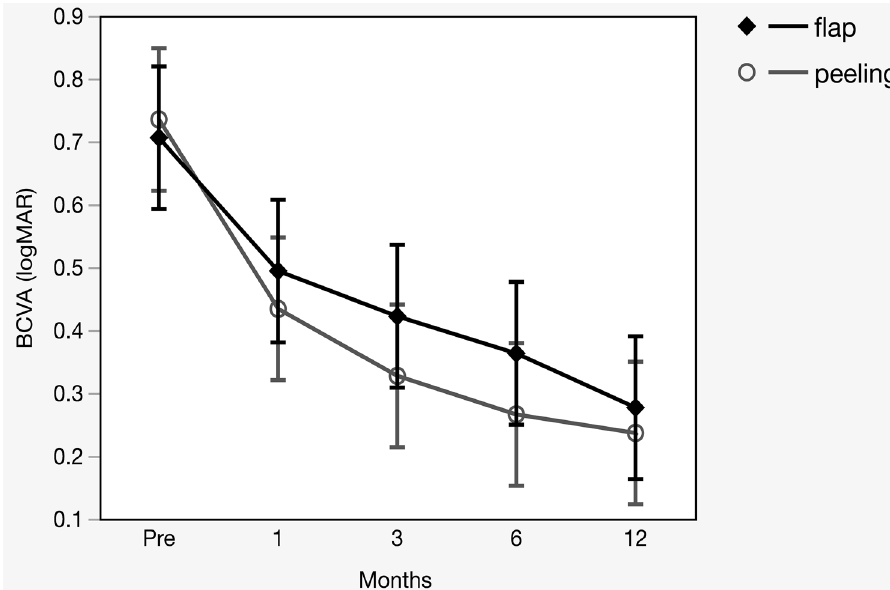
Figure 2. Change of pre-operative and postoperative best-corrected visual acuity (BCVA) in the flap group versus the peeling group. The change in BCVA in each group was assessed using the Steel test. Dot plots represent mean values, and whiskers represent 95% confidence intervals.